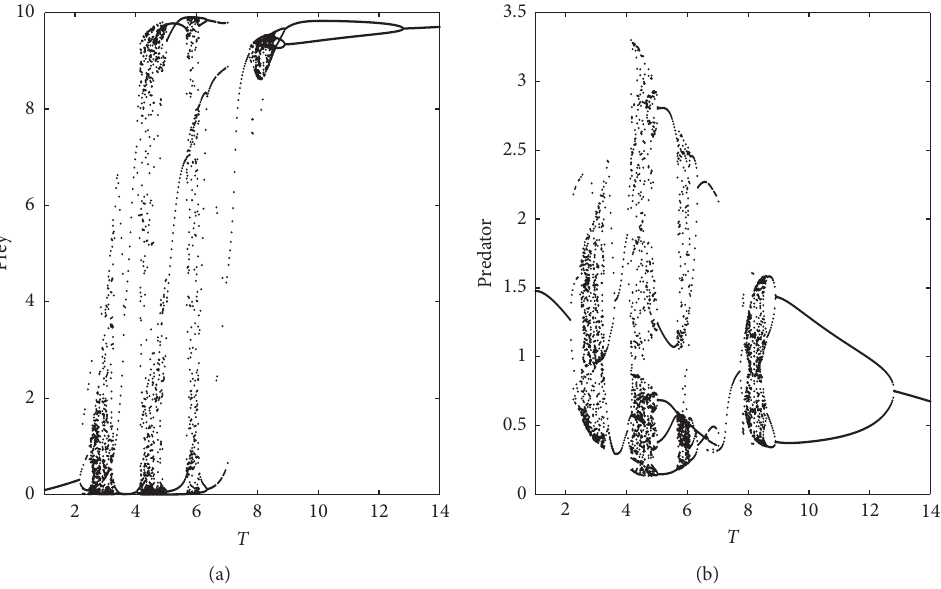
Bifurcation diagrams of model (1) with respect to T . The parameter values are as